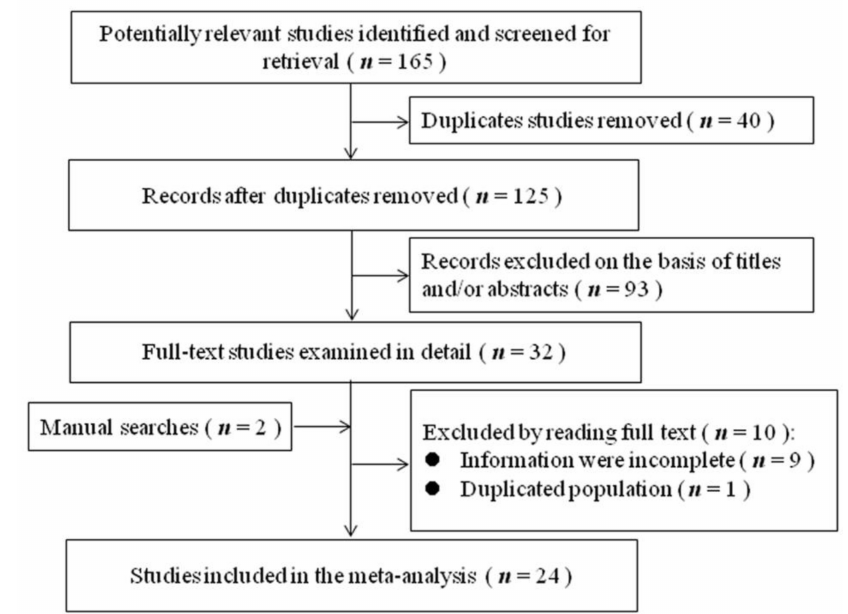
Figure 1. Flowchart of literature search and study selection. Table 1. Main characteristics of studies in the